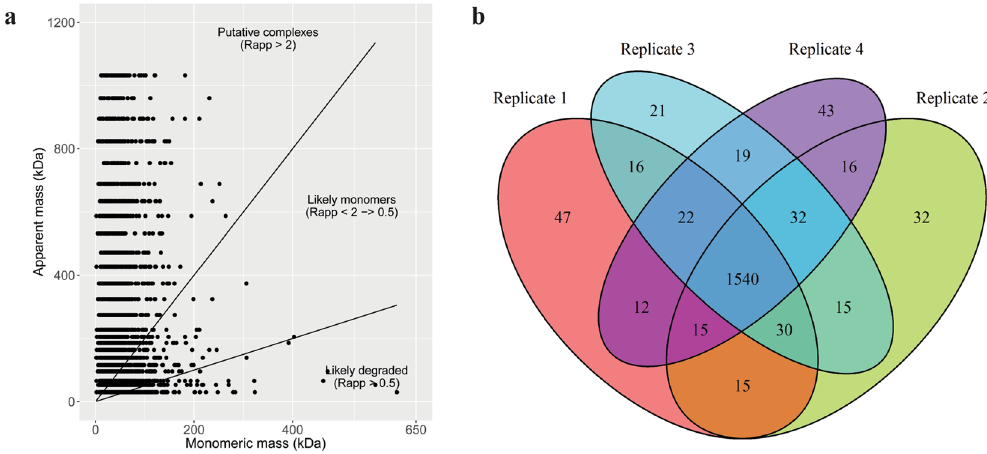
Figure 4. Identification of putative protein complexes using the HiT-Gel method. (a) The distribution of the apparent mass of the quantified proteins is shown as a scatterplot. Circles are representative of the apparent mass of the proteins (y-axis) as identified experimentally, in comparison to their TAIR10 annotated monomeric masses (x-axis). Rapp values indicate the oligomerization state of the proteins. Rapp values > 2 indicate putative complexes; Rapp values of between 0,5 and 2 describe proteins that likely exist as monomers; Rapp values of < 0,5 likely represent degraded proteins. (b) The overlap between proteins found to exist as a complex is shown between the four biological replicates as a venn